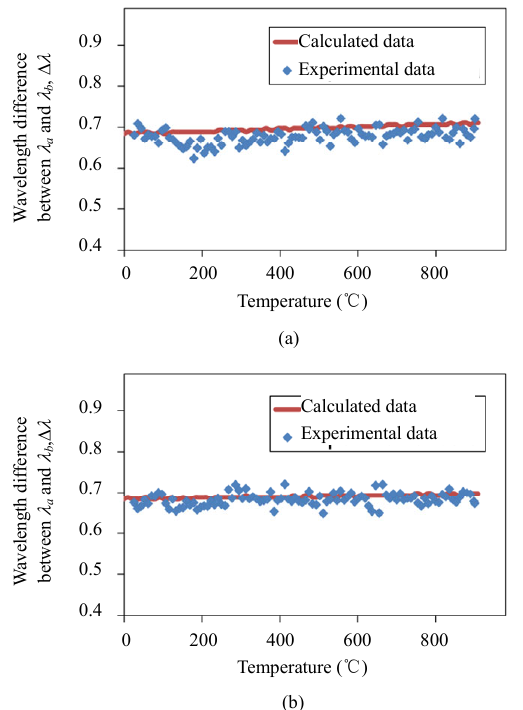
Fig. 5 Experimental data with linear fit for the wavelength difference between λ a and λ b as a function of a temperature, T (℃ ) for (a) non-treated fiber (Fiber 1), the slope value is 2.91 × 10 ‒ 2 pm /℃ and (b) CO 2 laser-treated fibers (Fiber 4), the slope value is 1.41 × 10 ‒ 2 pm /℃ .